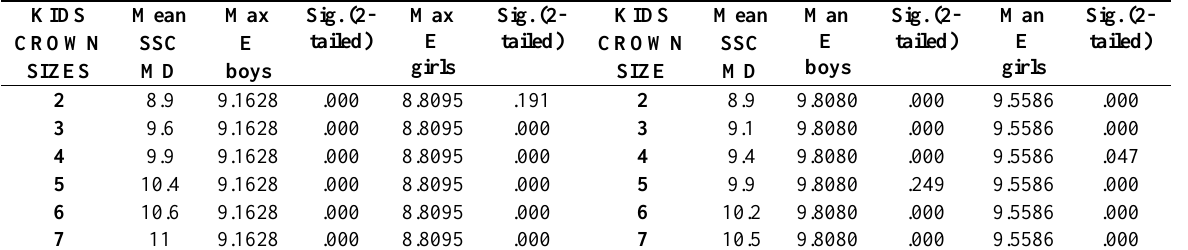
Table 4: Comparison between the MD measurements of KIDS CROWN SSC with second primary molars.